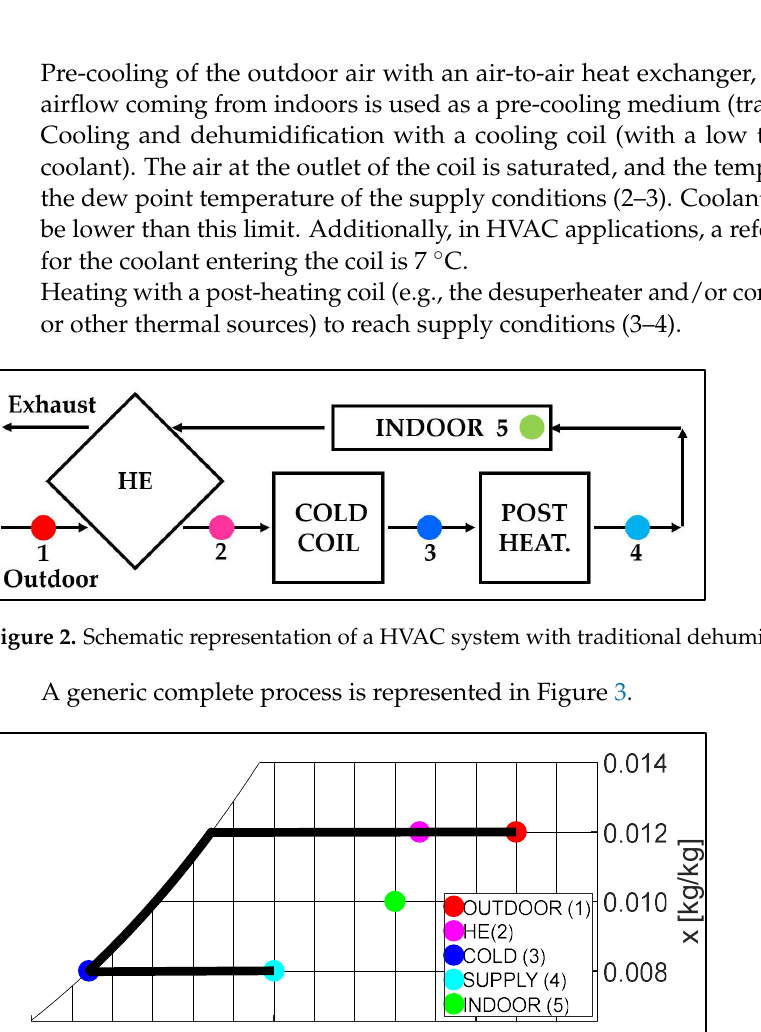
Figure 3. Transformations in an HVAC system with traditional dehumidification.